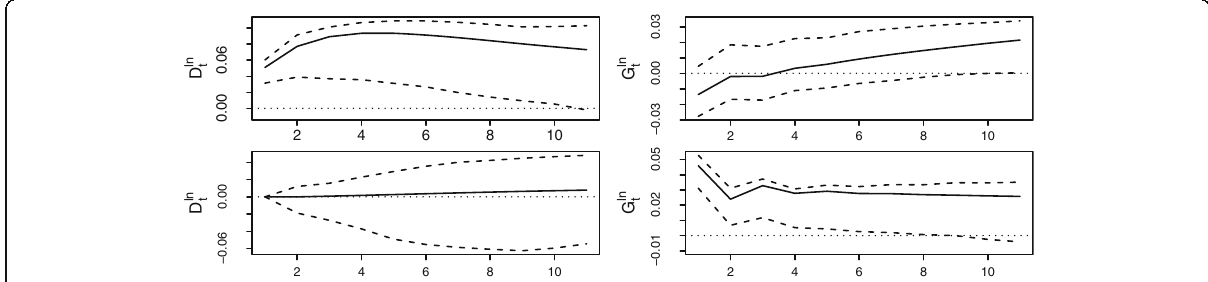
Fig. 2 Orthogonal impulse response functions with 95% bootstrap CI for recession phases. Top: from D ln